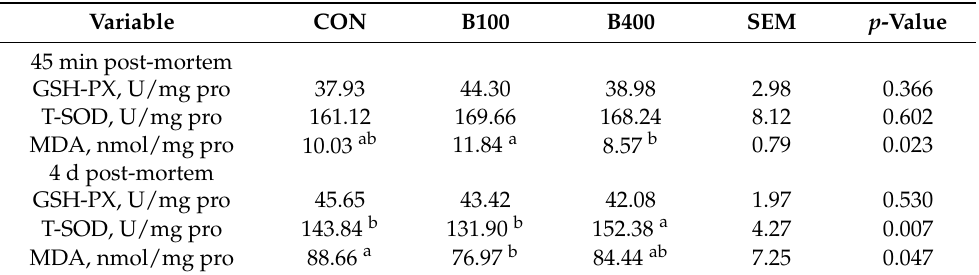
Table 7. Effects of dietary supplementation with bilberry extract on antioxidant capacity of breast muscle of yellow-feathered chickens at 63 d 1 .